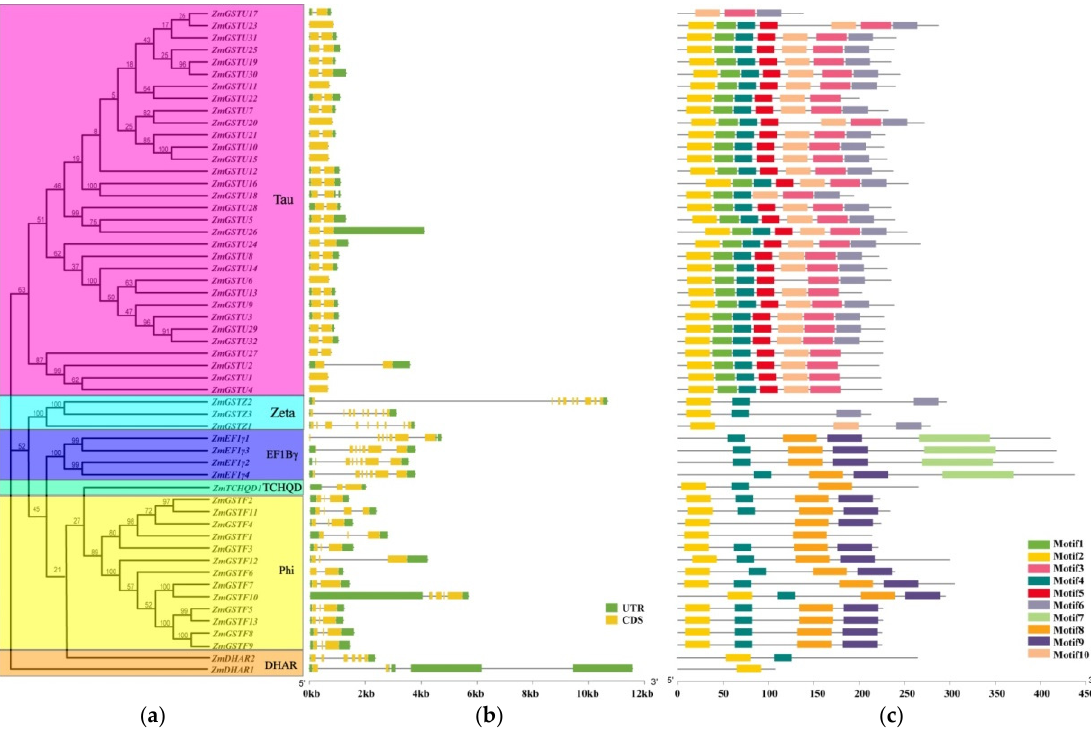
Figure 2. Phylogenetic relationships, gene structures, and protein domains of the ZmGST gene family. ( a ) Six ZmGSTs clusted into six groups in an unrooted ML tree constructed by MEGA7.0; ( b ) The intron/exon structures of ZmGSTs were analyzed by comparing genomic and cDNA sequences. CDS, UTR, and introns were represented by orange boxes, green boxes, and gray lines, respectively. The sizes of CDS and introns can be estimated using the ratio of the bottom; ( c ) Ten conserved motifs of ZmGSTs were generated by the online MEME tool. Different motifs were displayed using the different colored boxes. The lengths of proteins and motifs were estimated using the scale at the bottom.